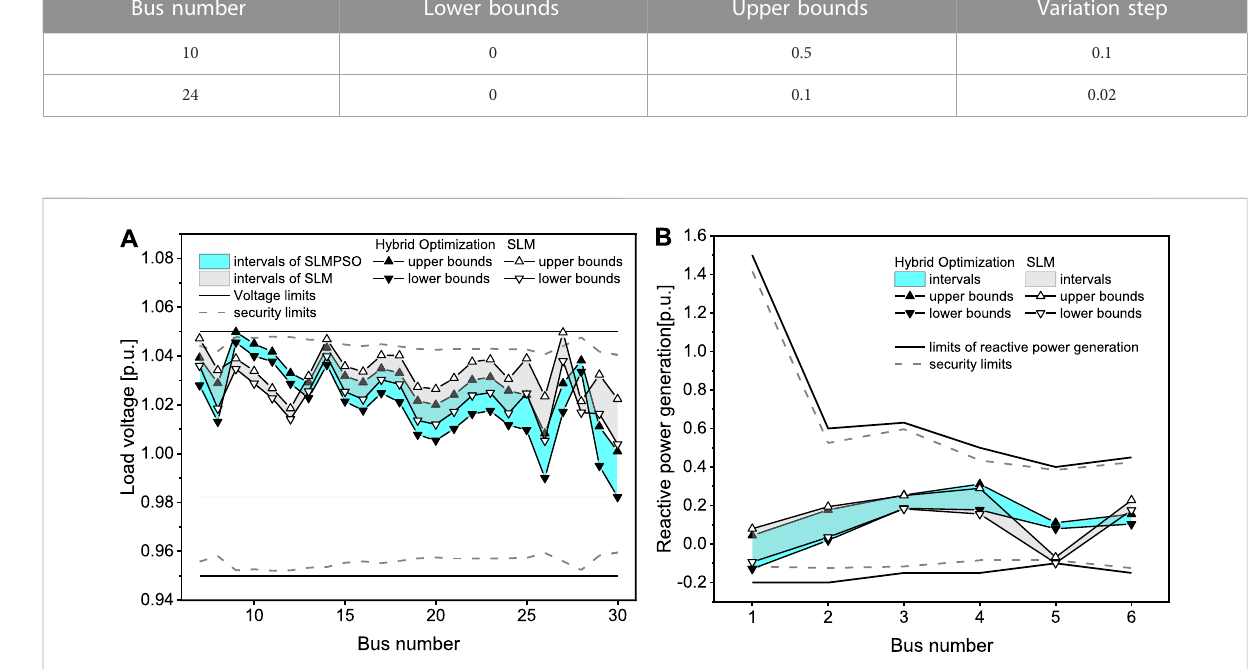
FIGURE 3 Results obtained by the hybrid optimization and SLM for the IEEE 30-bus system: (A) voltage magnitude and (B) reactive power